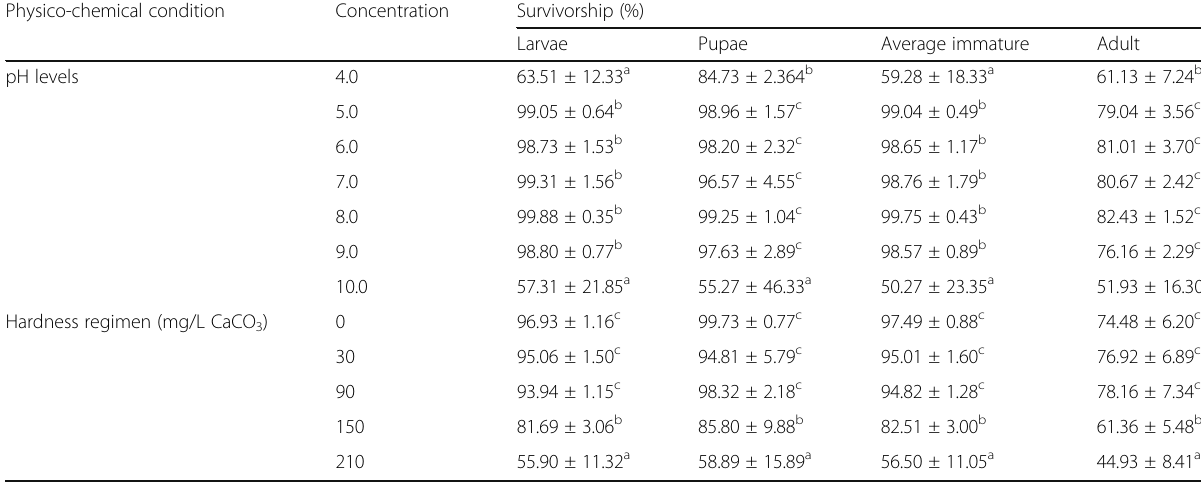
Table 3 Effects of water pH and hardness level on life stages ’ survivorship of Culex quinquefasciatus Physico-chemical